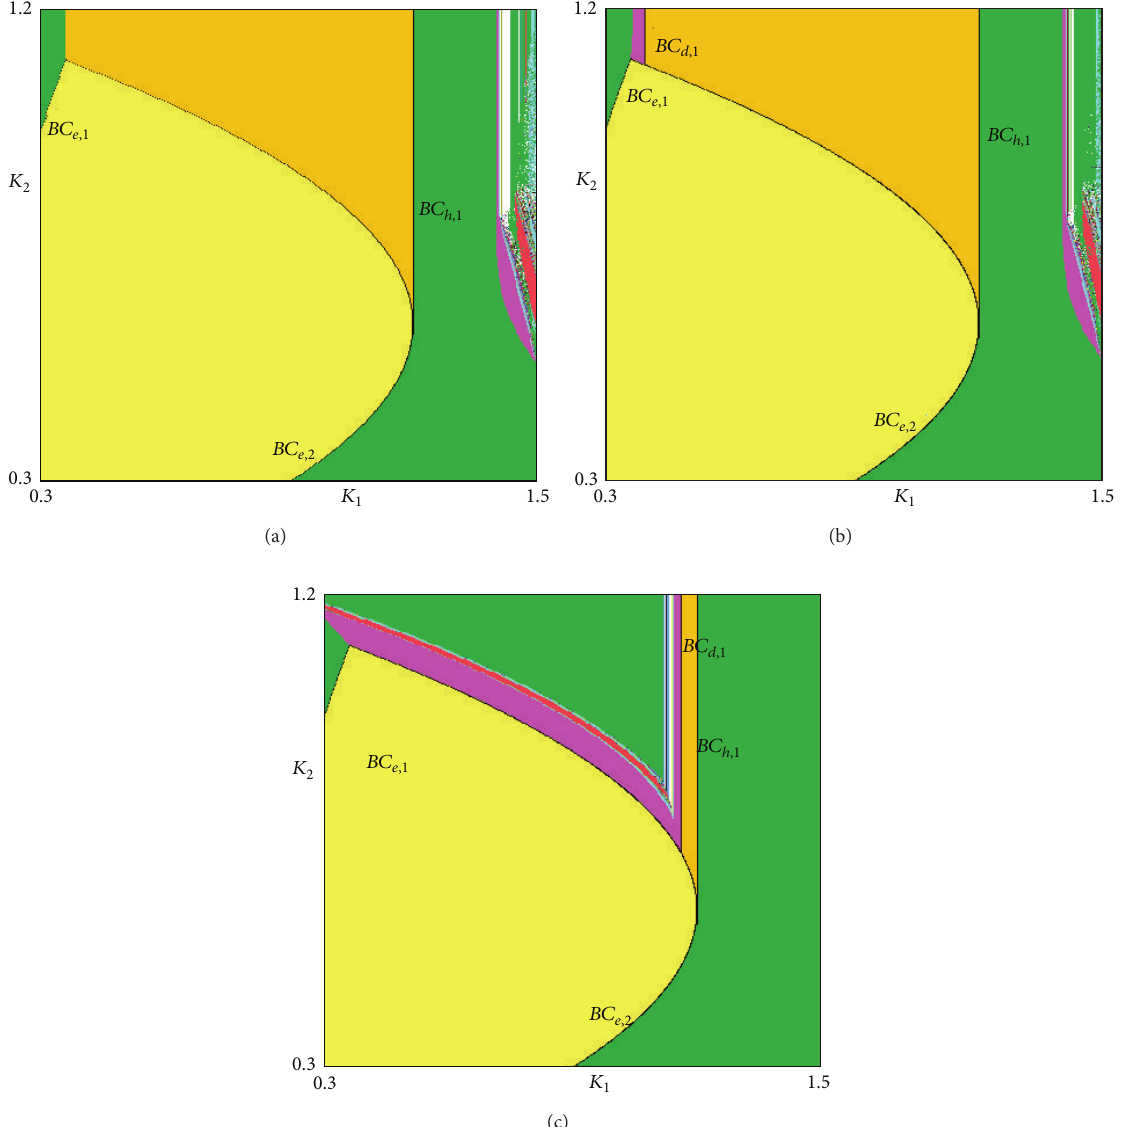
Figure 9: Two-dimensional bifurcation diagram on the (𝐾 1 , 𝐾 2 ) -parameter plane for map 𝑇 . Parameters: 𝑁 1 = 1.5 , 𝑁 2 = 1.2 , 𝜏 1 = 𝜏 2 = 4 , and 𝛾 1 = 1 . Panel (a) 𝛾 2 = 0.5 . Panel (b) 𝛾 2 = 0.56 . Panel (c) 𝛾 2 = 4 . Meaning of the colors of the regions as in Figure